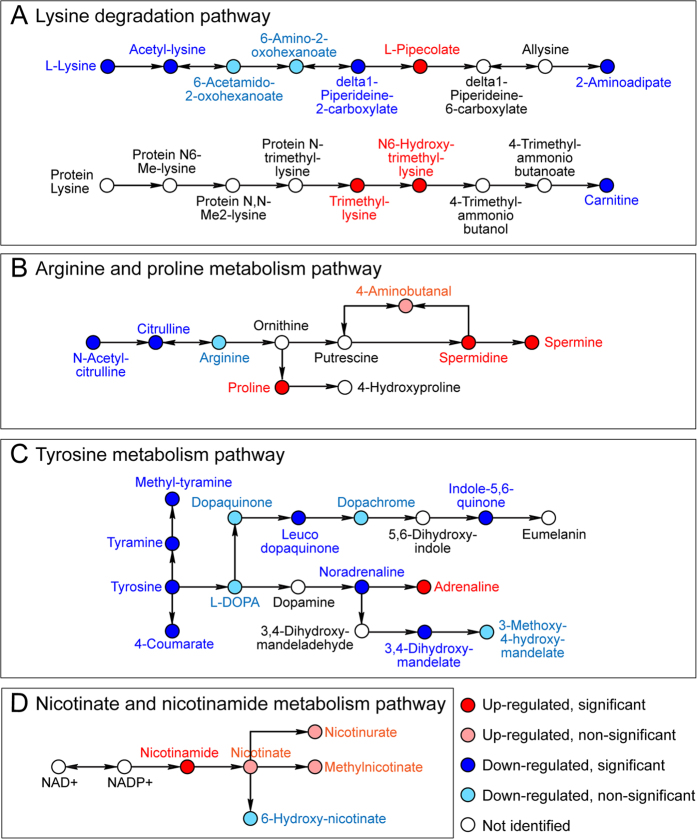
Potentially regulated metabolic pathways.Identified metabolites with direction of changes were indicated with different colored circles. The complete KEGG pathway maps including all the identified metabolites are displayed in Supplementary Fig. S3.